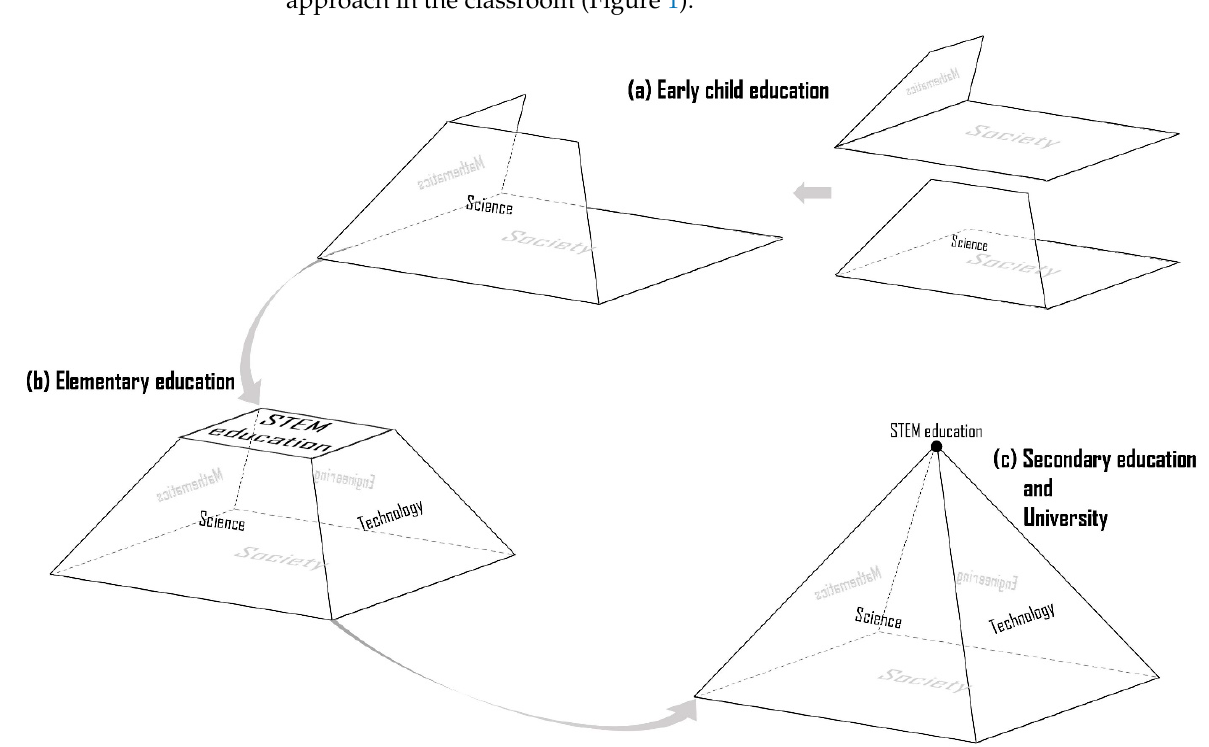
Figure 1. Implementation of the STEM approach in the different educational stages .